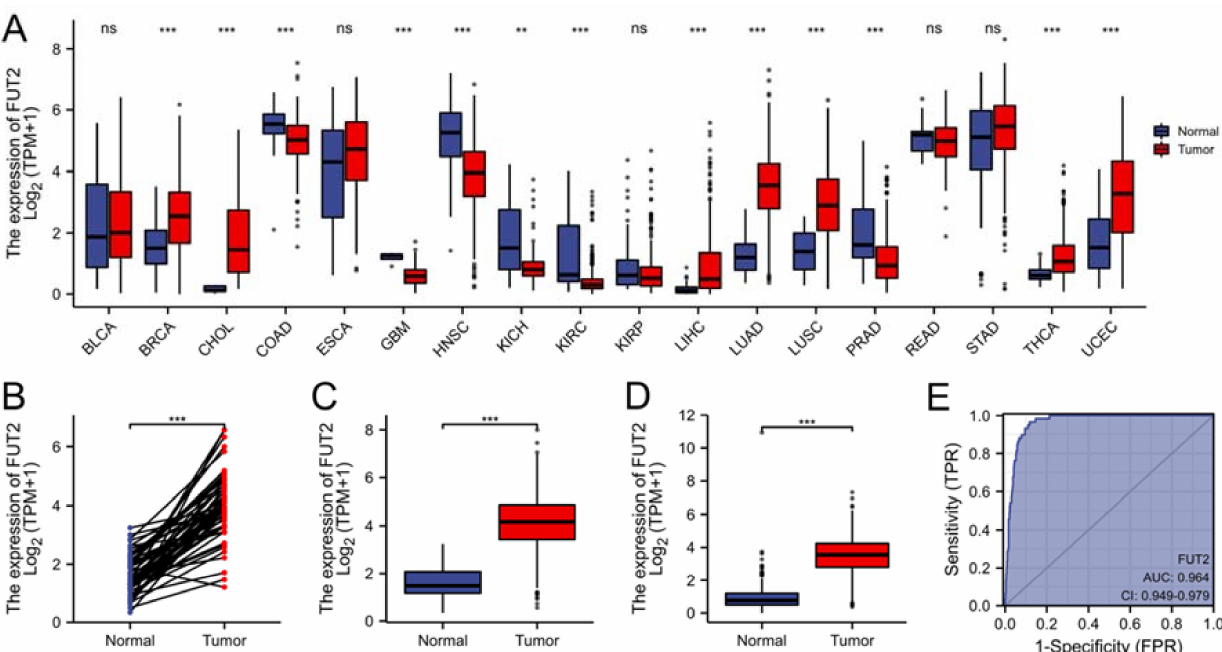
Figure 1. Bioinformatics analysis of FUT2 based on the TCGA and GTEx datasets. ( A ) The mRNA expression of FUT2 in different cancer types. ( B , C ) FUT2 expression in lung adenocarcinoma tissues and normal tissues in the TCGA dataset ( B ) and the TCGA + GTEx dataset ( C ). ( D ) FUT2 expression in lung adenocarcinoma and adjacent normal tissues. ( E ) ROC curve of FUT2 mRNA expression in the lung adenocarcinoma cohort (AUC = 0.964) (ns: No significance, ** p < 0.01, and *** p <